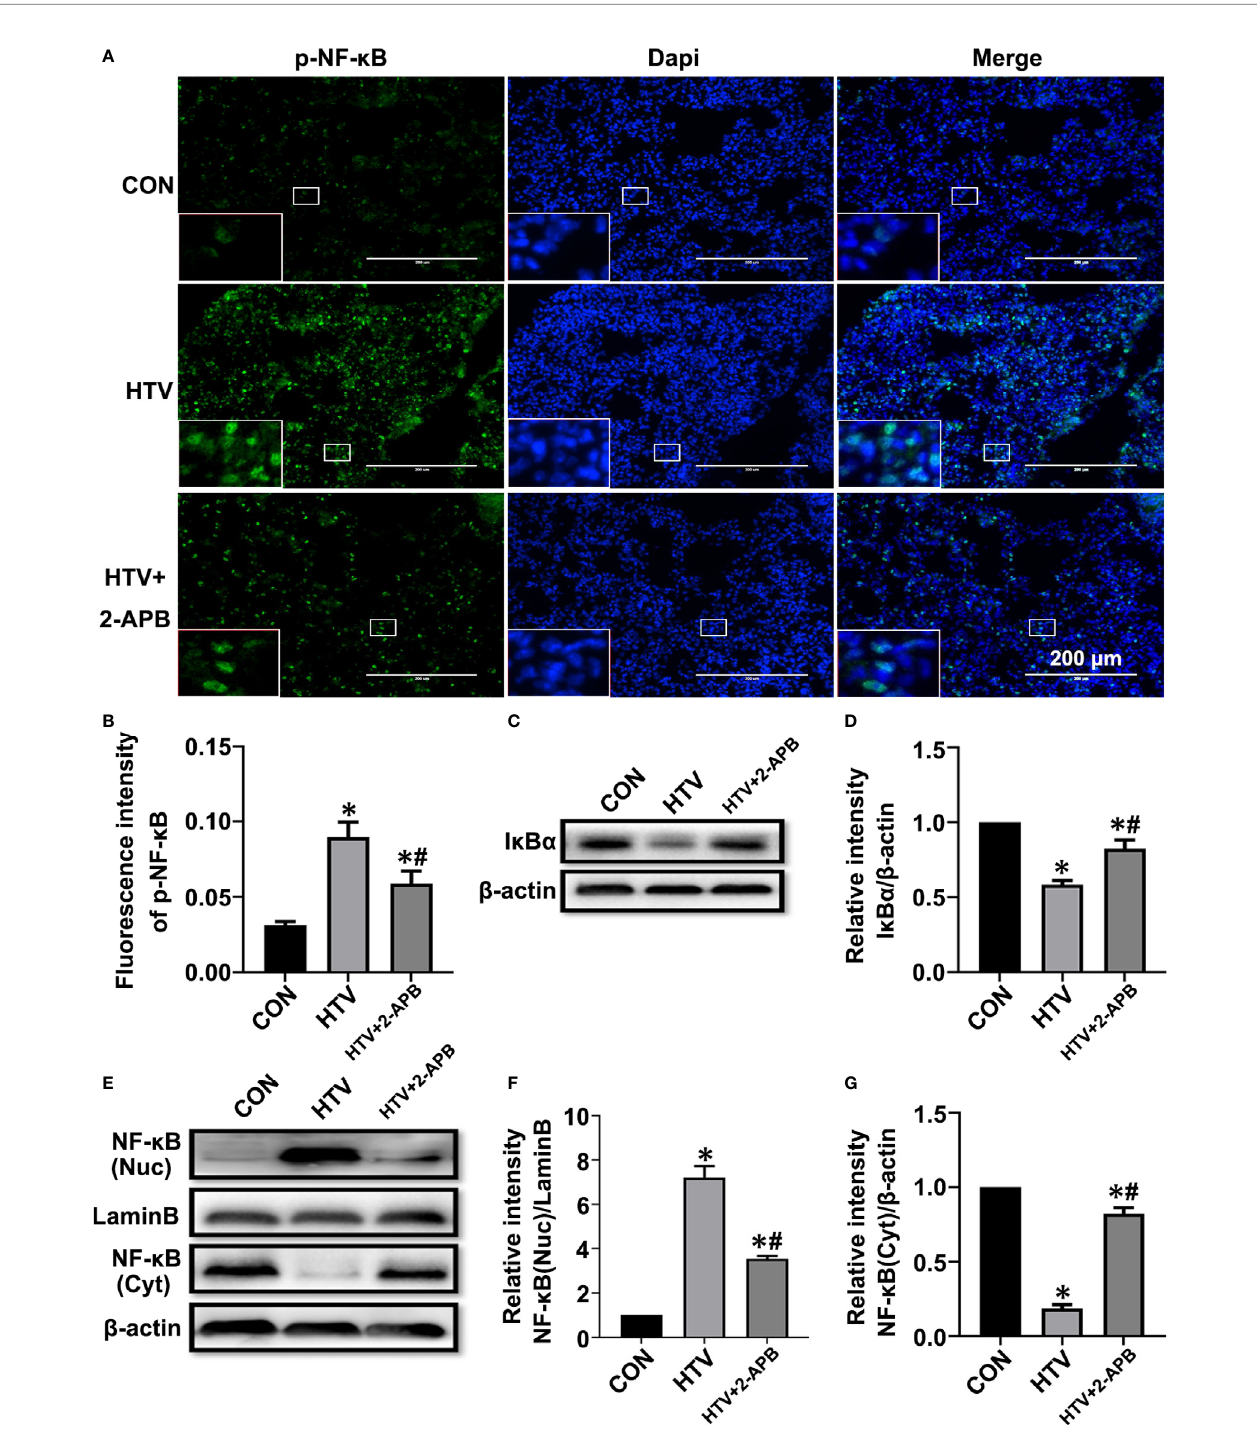
FIGURE 6 | 2-APB inhibits activation of NF- k B signaling pathway in HTV-treated mice. (A, B) Immuno fl uorescence photomicrographs and quanti fi cation analysis of p-NF- k B p65 in lung tissues of group CON, HTV and HTV+2-APB mice. Dapi (blue) was used to stain the nuclei. Scale bar: 200 m m. An inset picture was employed to show the indicated area at 4X magni fi cation. (C, D) Representative immunoblots of I k B a in lung extracts and densitometric analyses of I k B a . (E – G) Representative immunoblots of NF- k B p65 in nucleus and cytoplasm, and densitometric analyses of NF- k B p65. Data are expressed as means ± SD (n = 6 per group). * P < 0.05 vs . CON group. # P < 0.05 vs . HTV